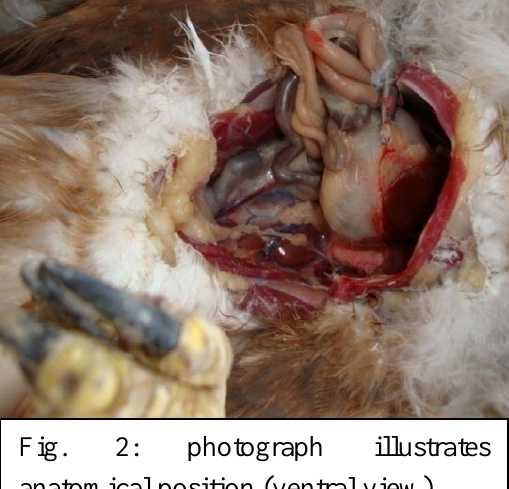
Fig. 1: photograph of healthy mature golden eagle.